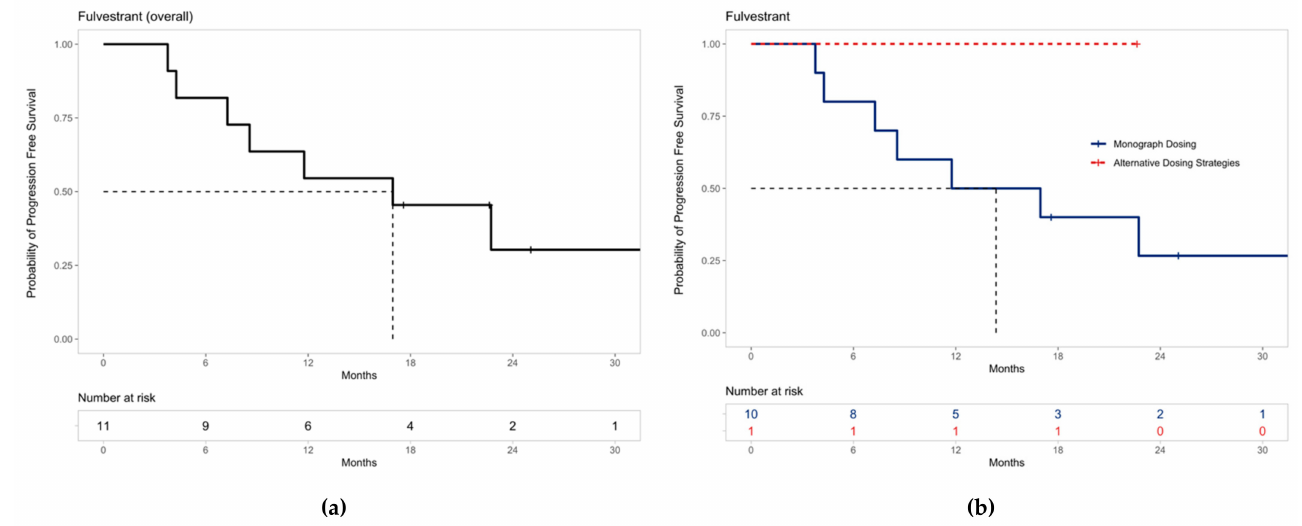
Figure 4. Progression-free survival for patients receiving palbociclib with fulvestrant: ( a ) The median PFS was 16.97 months (95% CI 8.57–not estimable) for all patients receiving palbociclib with fulves- trant. ( b ) The median PFS for patients receiving fulvestrant with palbociclib prescribed monograph dosing was 14.4 months (95% CI 7.27–not estimable). Median PFS could not be estimated for patients prescribed alternative dosing strategies due to the limited sample size. Note: ‘+’ points along the curves represent censored observations.